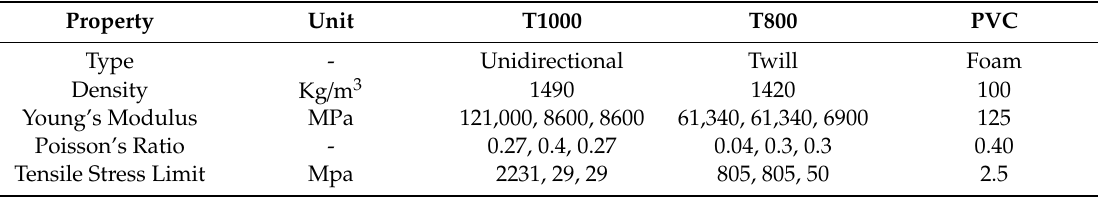
Table 1. Main material characteristics and properties.